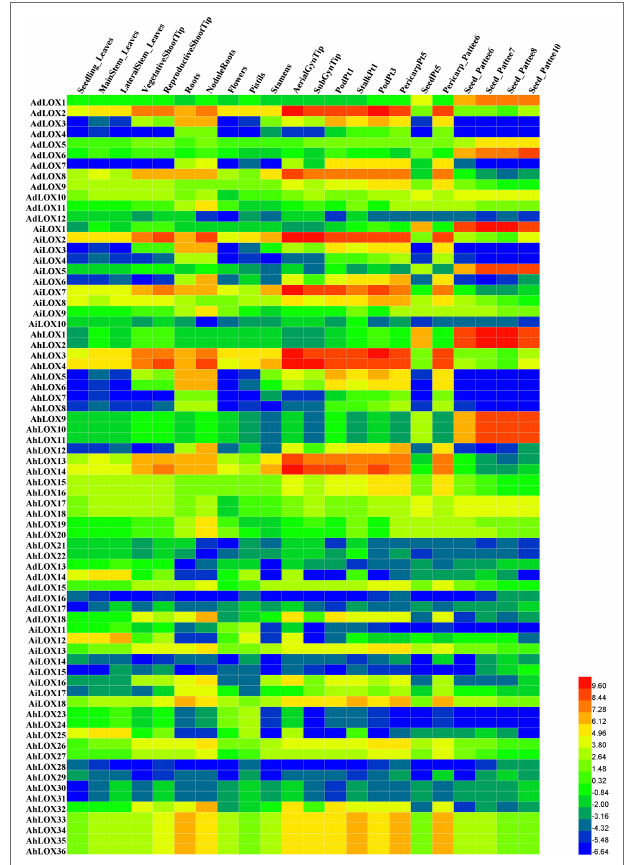
FIGURE 7 | Expression profiles of LOX genes in 22 different peanut tissues. The heatmap was generated by Heml software, and the fragments per kilobase of transcript per million fragments (FPMK) values of peanut LOX genes were log2-transformed. The red and blue colors represent the maximum and minimum values,